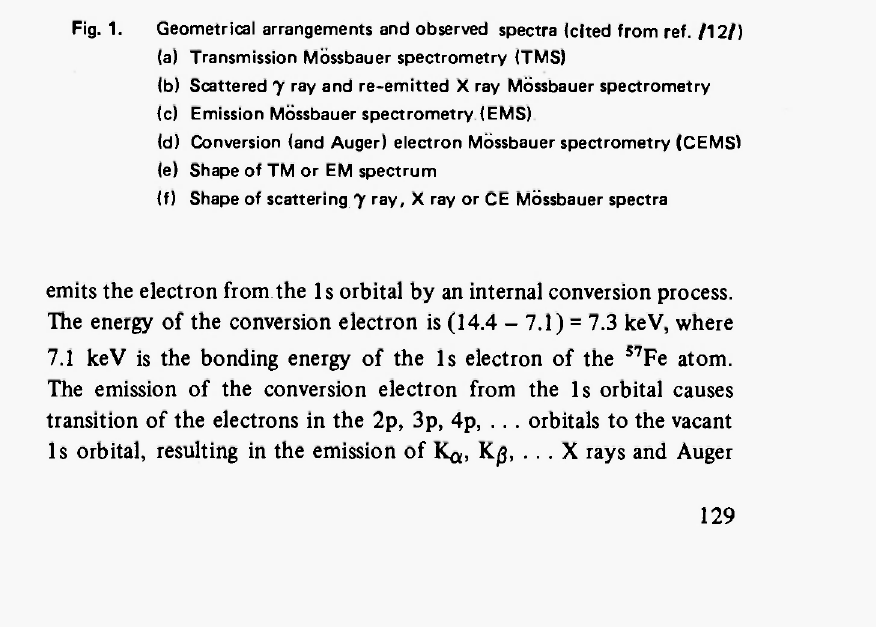
(a) Transmission Mössbauer spectrometry (TMS) (b) Scattered y ray and re-emitted X ray Mössbauer spectrometry (c) Emission Mössbauer spectrometry